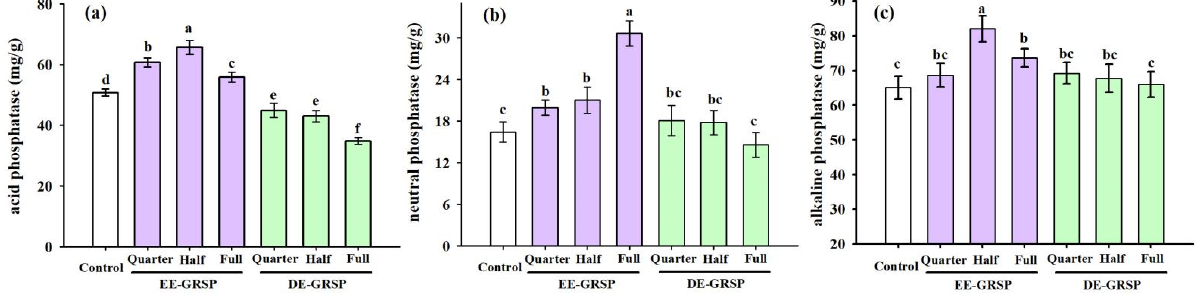
Figure 7. Effects of exogenous GRSP on soil acid ( a ), neutral ( b ), and alkaline ( c ) phosphatase activity in trifoliate orange seedlings. Data (mean ± SD, n = 4) followed by different letters above the bars indicate significant differences ( p < 0.05) between treatments.